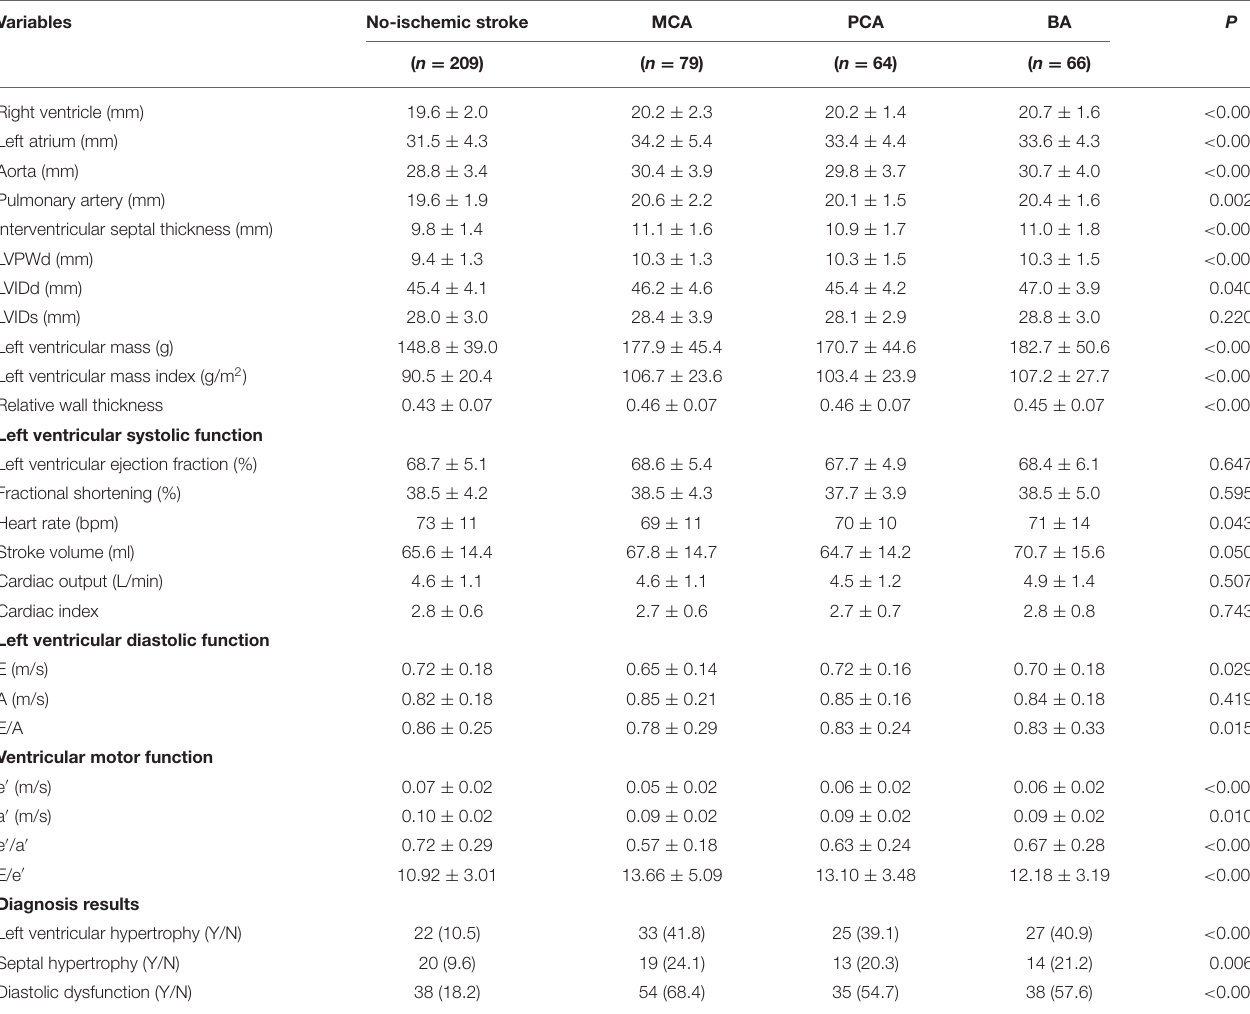
TABLE 2 | The outcomes of echocardiogram between the ischemic stroke group (MCA, PCA, BA) and no-ischemic stroke group.